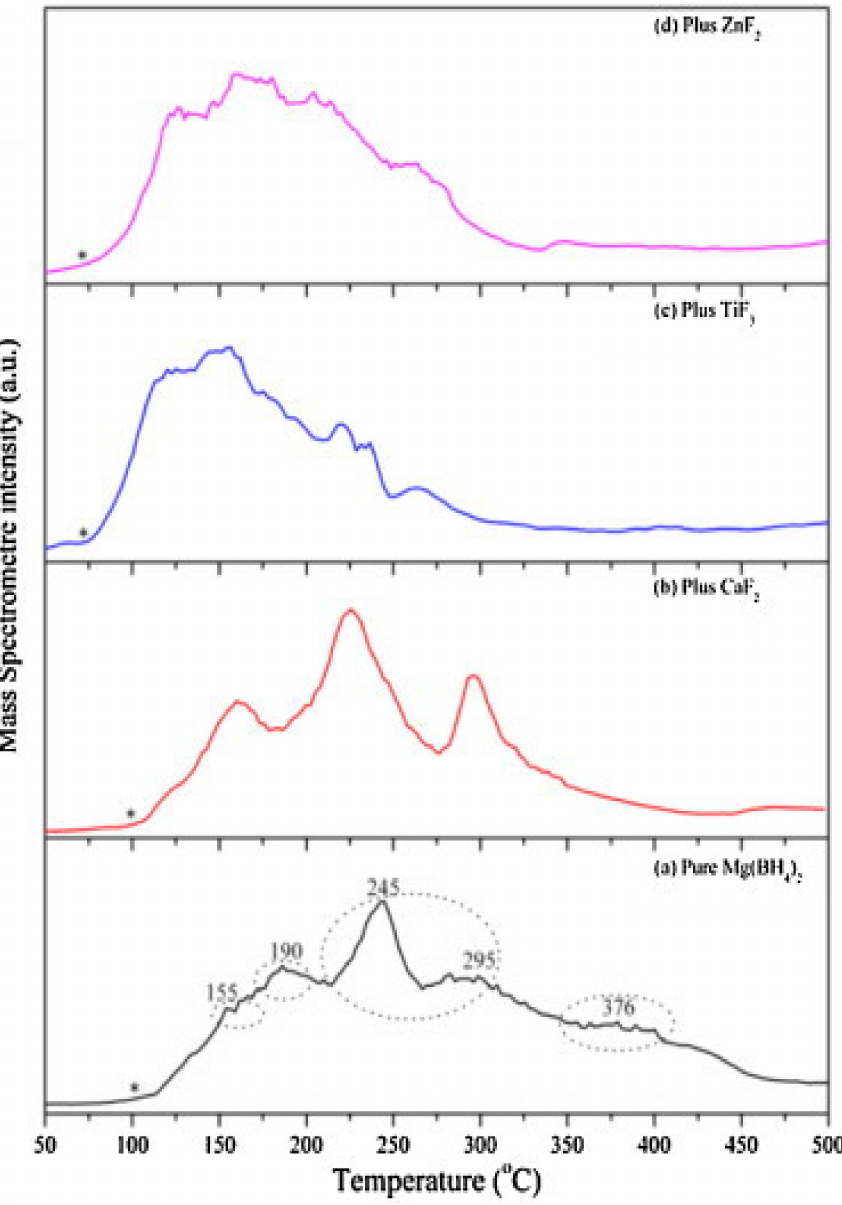
Figure 7. Temperature desorption curves for ( a ) pristine Mg(BH 4 ) 2 and fluoride-doped Mg(BH 4 ) 2 : ( b ) CaF 2 ; ( c ) TiF 3 and ( d ) ZnF 2